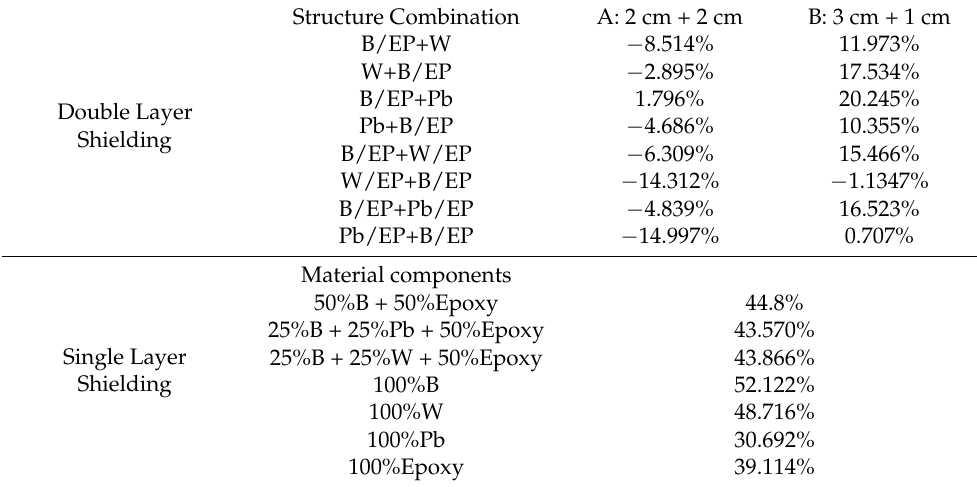
Table 1. Radiation protection efficiency ( RPE ) of single-layer and double-layer shielding